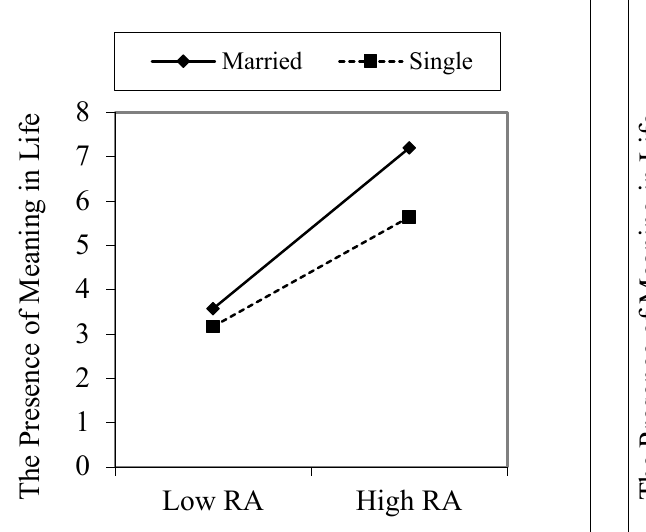
Figure 3. Moderation role of working St. between RA and depression . 4.6. The Outcomes of the Suggested Model and Hypotheses After performing the correlation, direct, mediation, and interaction analyses using the factors in Figure 1, which was shown as the conceptual model of the research, the coefficients and significance values shown in Figure 2 were obtained. The effect’s direction is shown by the direction of the arrow on the line connecting the two variables, the values